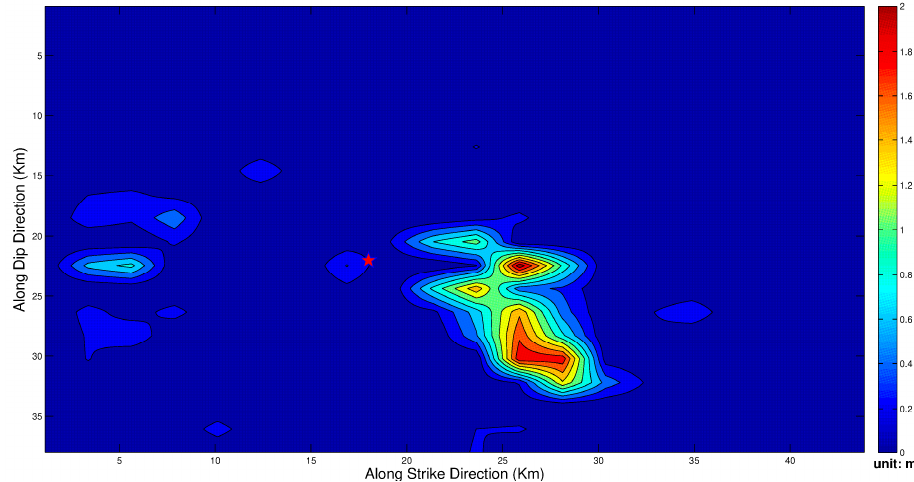
Figure 5. Slip distribution on the indicated fault with distance used as a reference.